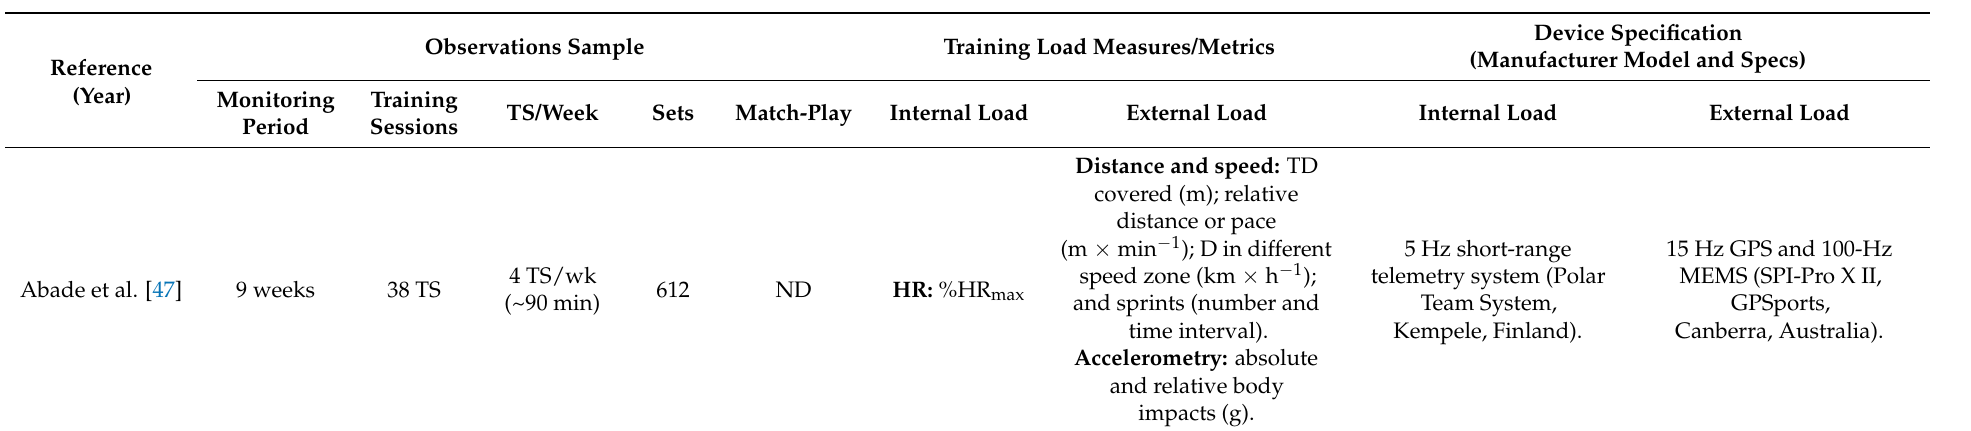
Table 4. Methodological approaches of included